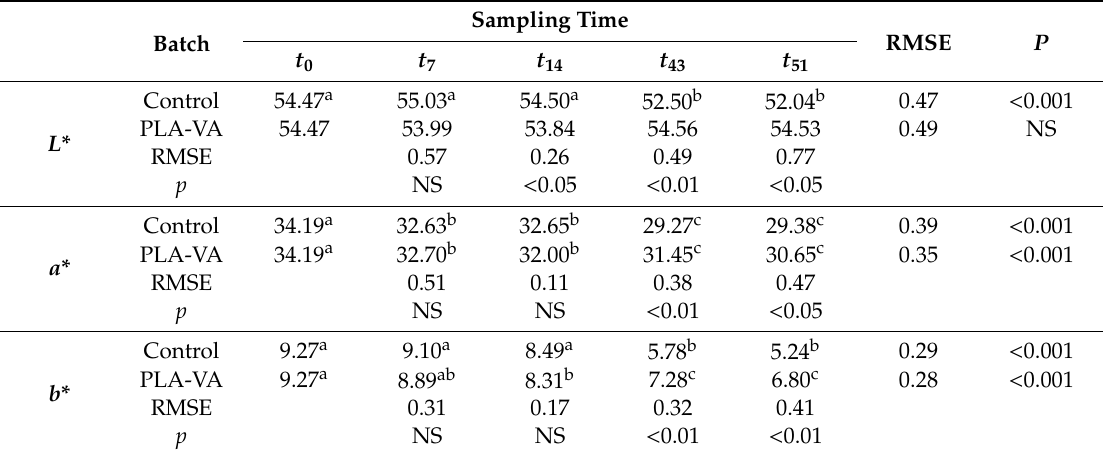
Table 6. Color parameters of salami vacuum packed without film (control) and vacuum packed with vanillyl alcohol (PLA-VA) films during refrigerated storage.